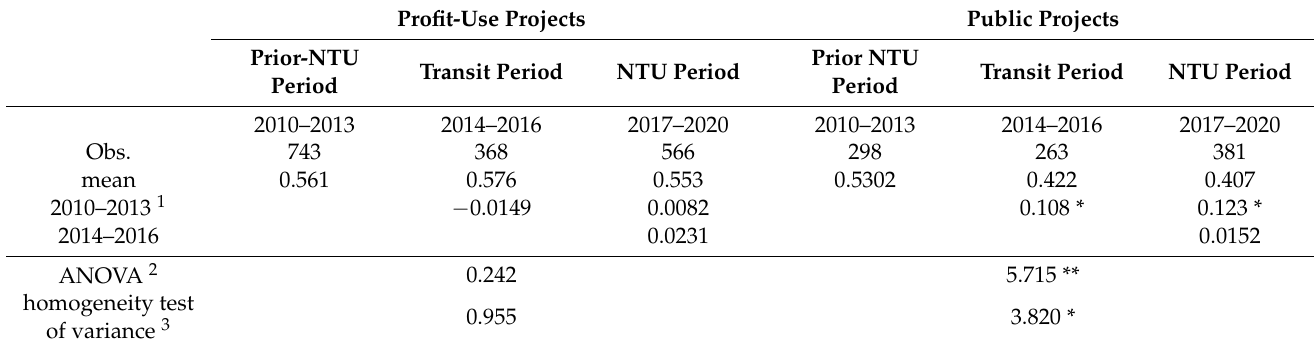
Table 3. Multiple comparisons of centralization of development projects between different